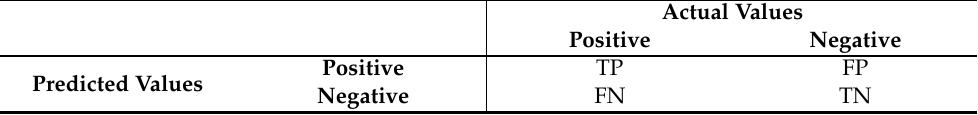
Table 5. Confusion Matrix.